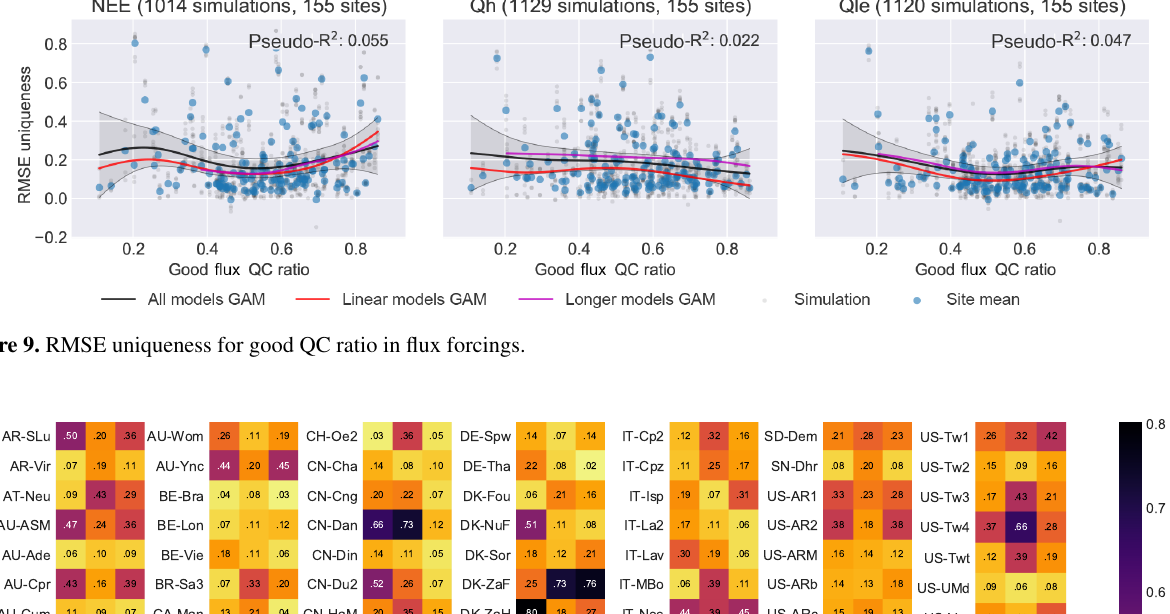
DE-Spw DE-Tha DK-Fou DK-NuF DK-Sor DK-ZaF DK-ZaH ES-LgS ES-Ln2 FI-Hyy FI-Jok FI-Lom FI-Sod FR-Fon FR-Gri FR-LBr FR-Pue GF-Guy